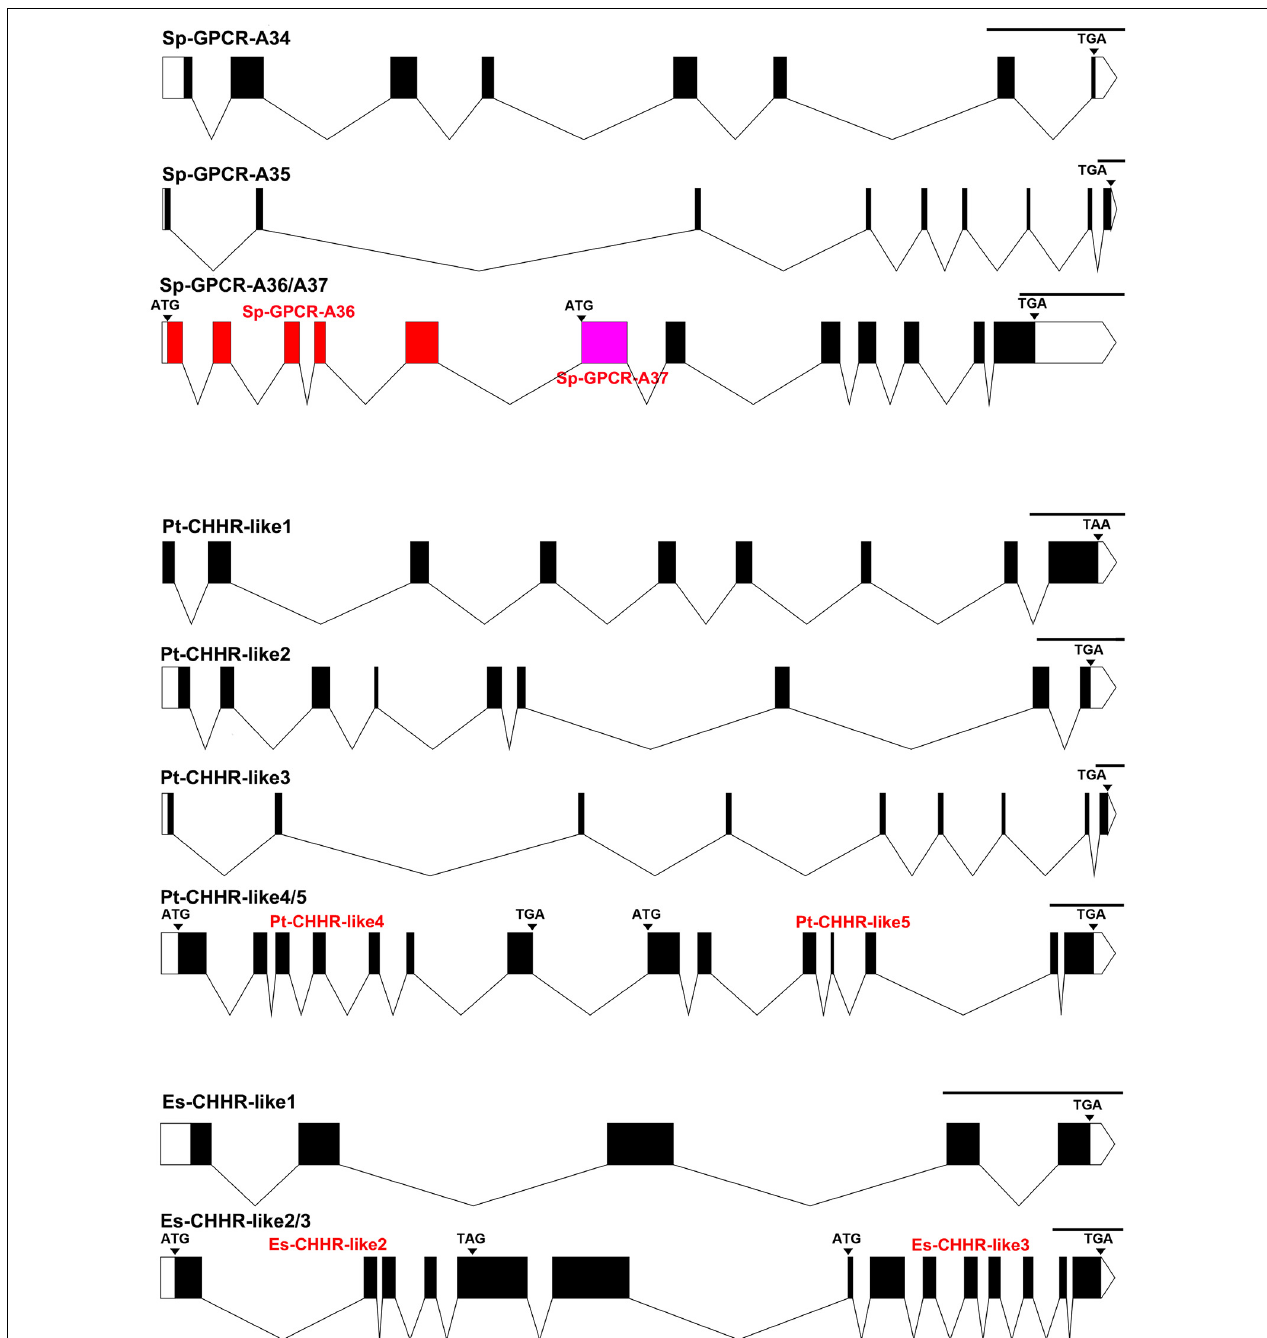
FIGURE 4 | Gene structures of CHH GPCRs obtained from genomic assembles of S. paramamosain, P. trituberculatus , and E. sinensis . Schematic diagrams showing the putative CHH GPCRs genomic structures identified in S. paramamosain, P. trituberculatus , and E. sinensis . Blocks and lines represent exons and introns, respectively. Black areas of the blocks represent the CDs of CHHs. In the schematic diagram of Sp-GPCR-A36-A37 , red blocks represent specific exons of Sp-GPCR-A36 gene, pink blocks represent specific exon of Sp-GPCR-A37 gene, and the black blocks represent their common areas. Scale length is 1000 base